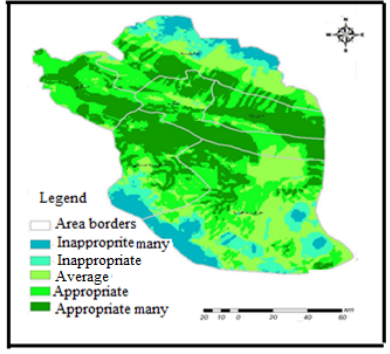
Fig. 2. Model of assessment for Isfahan township ecotourism potential for ecotourism application in GIS